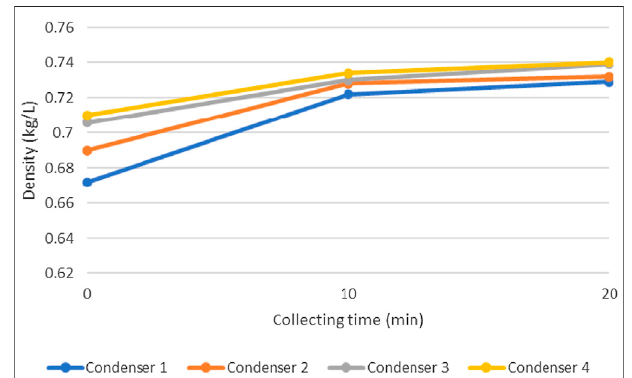
FIGURE 11 | Densities of products from each condenser at different collecting time (pyrolysis temperature (cid:1) 450 ° C).